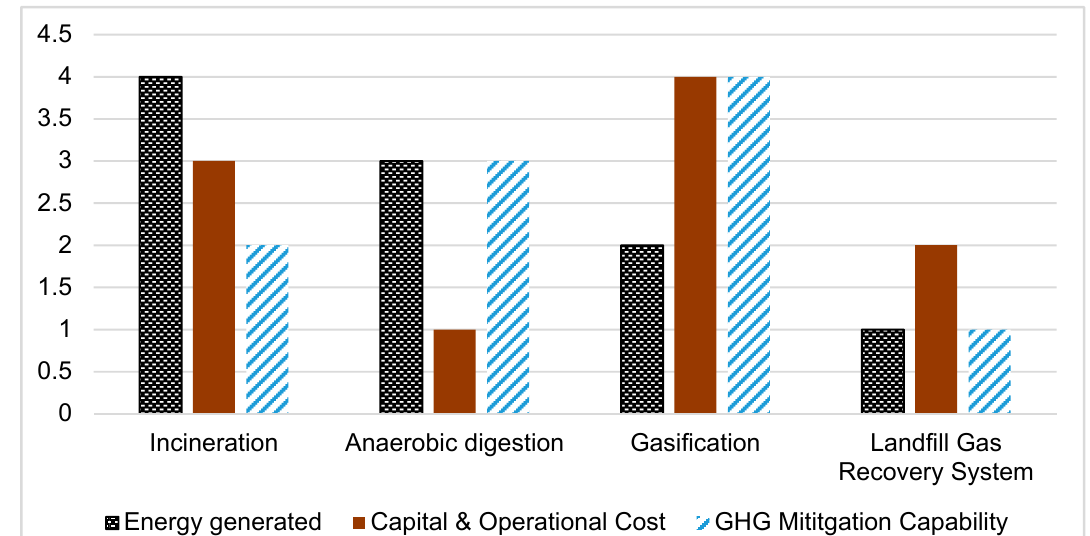
Figure 12. Comparison of different WTE technologies in terms of energy potential, cost, and greenhouse gas (GHG) mitigation ability [16].